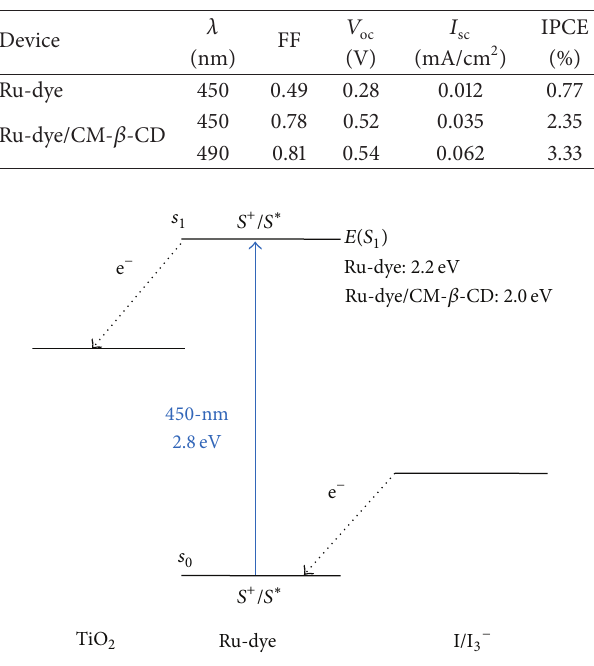
Table 1: Photovoltaic performance of devices prepared in the absence and presence of a CM- 𝛽 -CD layer.